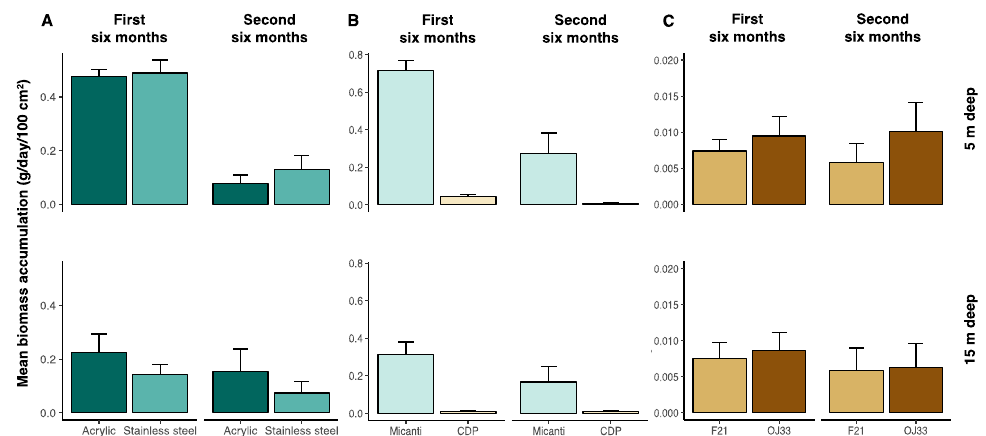
Figure 4. Mean biomass accumulation (g/day/100 cm 2 ± SE) on each plate, deployed at different times during the first and second 6 months of the experiment at the two deployment depths. ( A ) Untreated materials (acrylic versus stainless steel), ( B ) the two “eco-friendly” AF strategies (Micanti versus CDP), and ( C ) the two not eco-friendly AF paintings (F21 versus OJ33). Note the different y -axis scales.